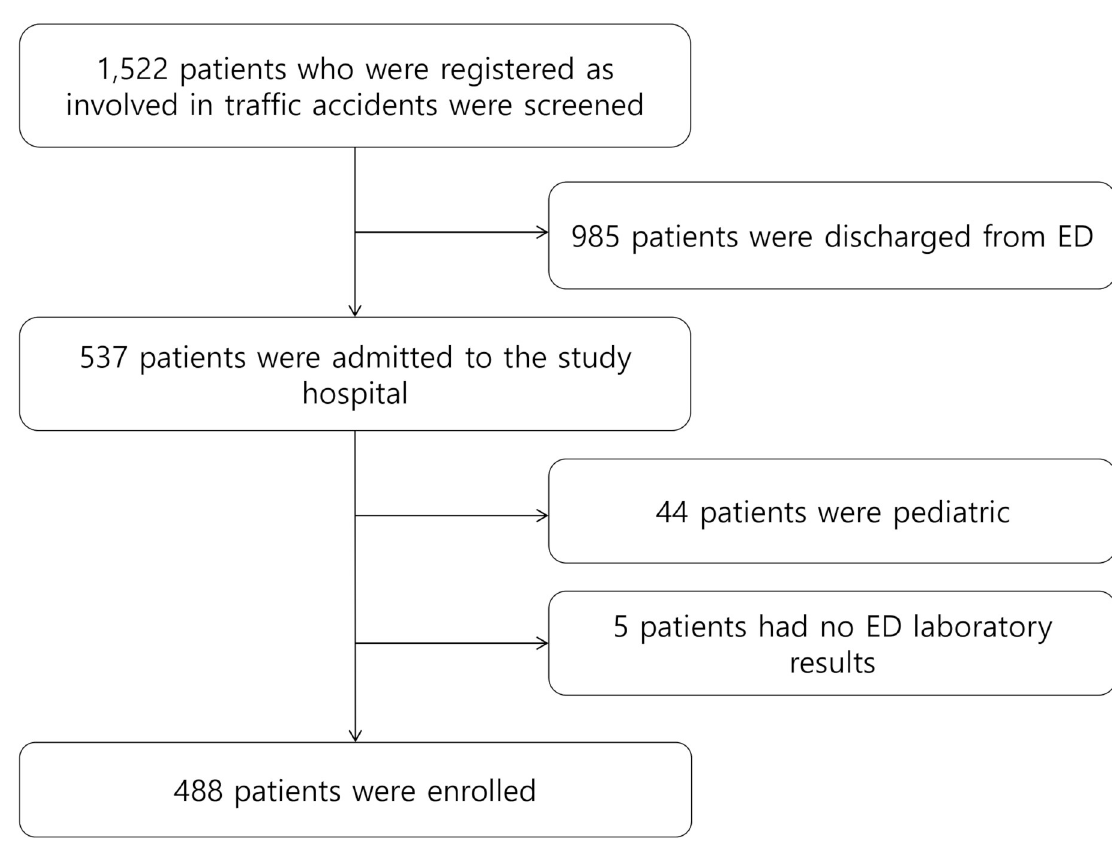
Fig 1. The Standards for the Reporting of Diagnostic Accuracy flow diagram for the